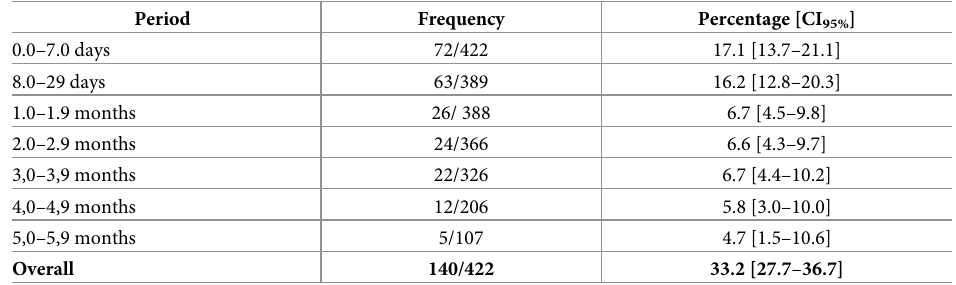
Table 2. Proportion of lactating mothers who encountered problems during different periods from delivery to six months.